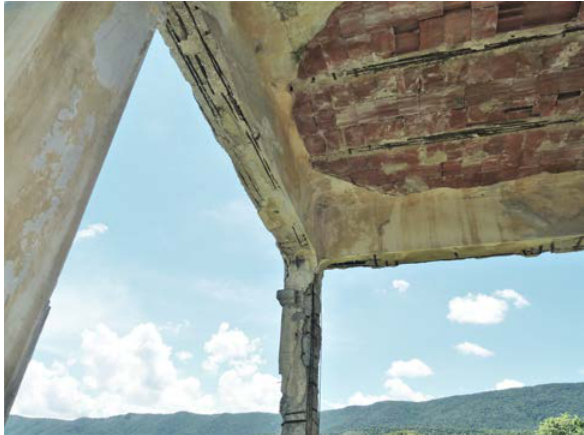
Figure 17. Floor